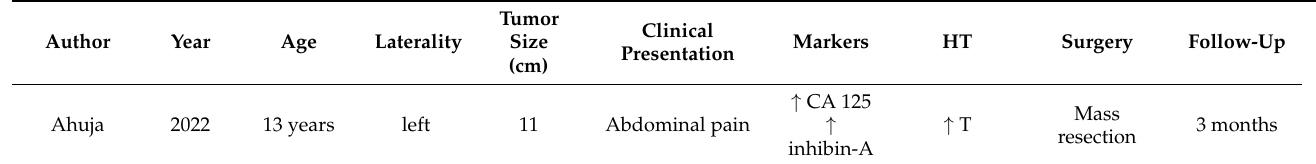
Table 2. List of the clinical cases reviewed in the literature and their characteristics: tumor size, laterality, age of the patient, clinical manifestations at entry, markers, blood test results, macroscopic appearance, type of surgery performed, and microscopic characteristics. Legend. ↑ : increase in reported